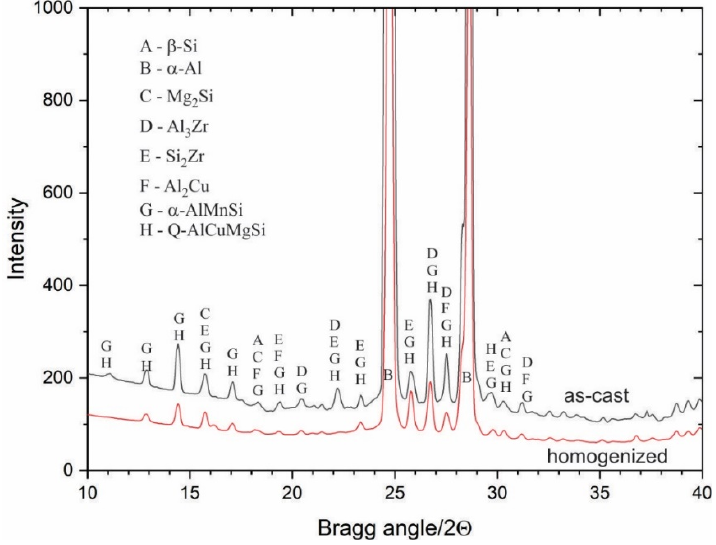
Figure 5. X-ray diffraction patterns of AA 6086 in the as-cast condition and after homogenization treatment. The peak positions of all phases found in the microstructure are indicated, showing strong overlapping of peaks.